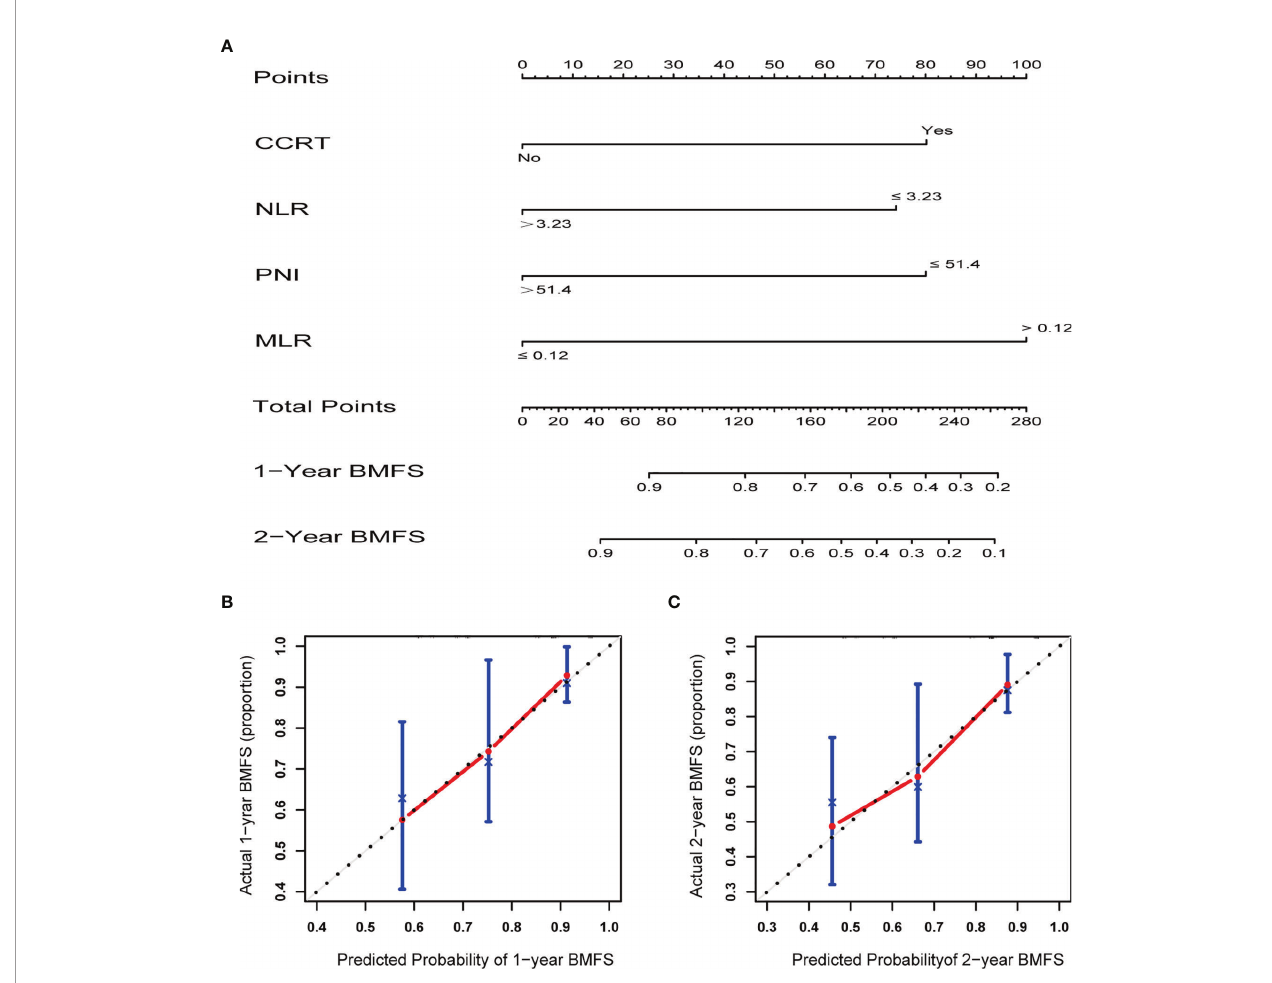
FIGURE 2 | (A) Nomogram for prediction 1- and 2-year brain metastasis free survival of stage III small cell lung cancer. (B) Calibration curves demonstrating the probability of 1-year BMFS between the prediction and the actual observation. (C) Calibration curves demonstrating the probability of 2-year BMFS between the prediction and the actual observation. X-axis represents the nomogram predicted probability, and Y-axis represents the actual